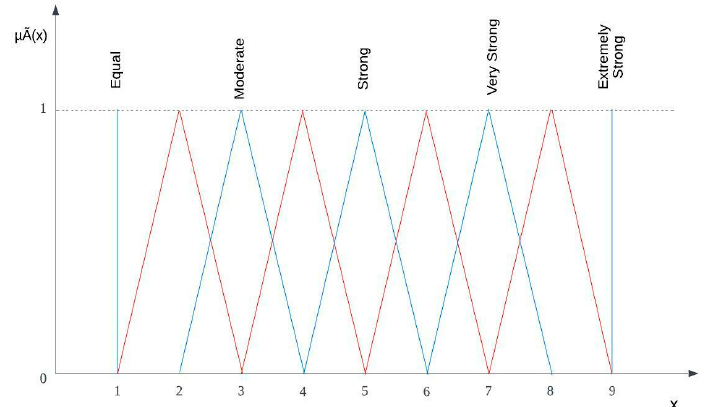
Figure 6. Fuzzy AHP.